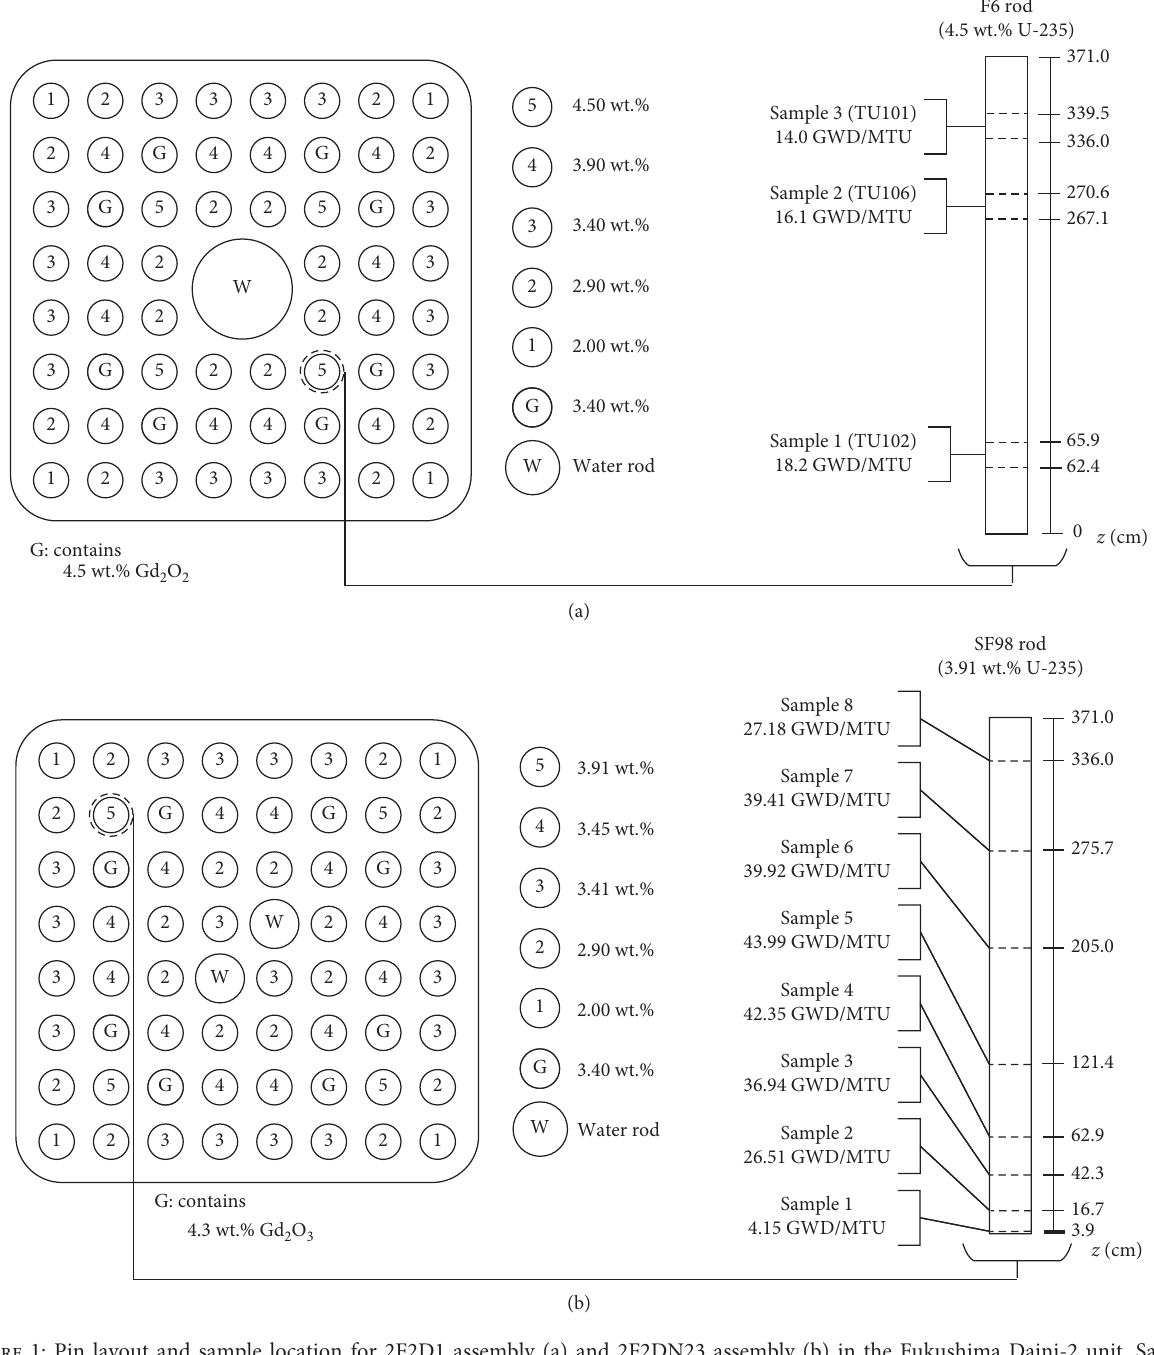
Figure 1: Pin layout and sample location for 2F2D1 assembly (a) and 2F2DN23 assembly (b) in the Fukushima Daini-2 unit. Sample thickness in SF98 rod is too thin for display ( ∼ 0 .